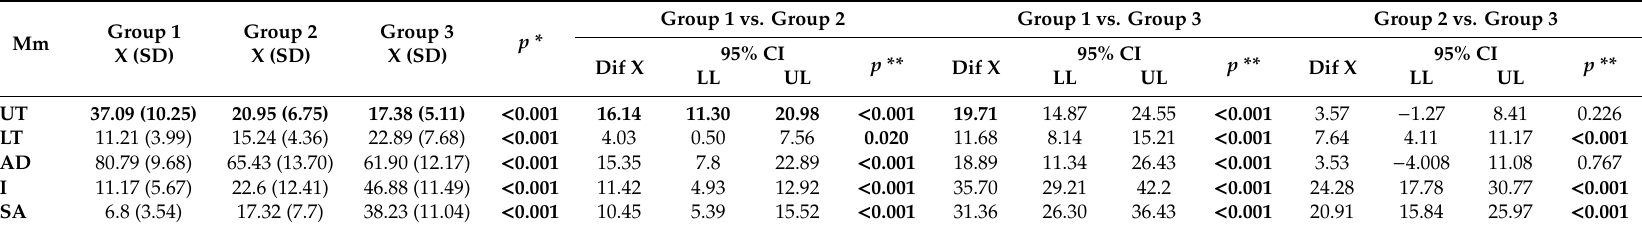
Table 6. The amplitude of muscle activity (RMS%). Flexion